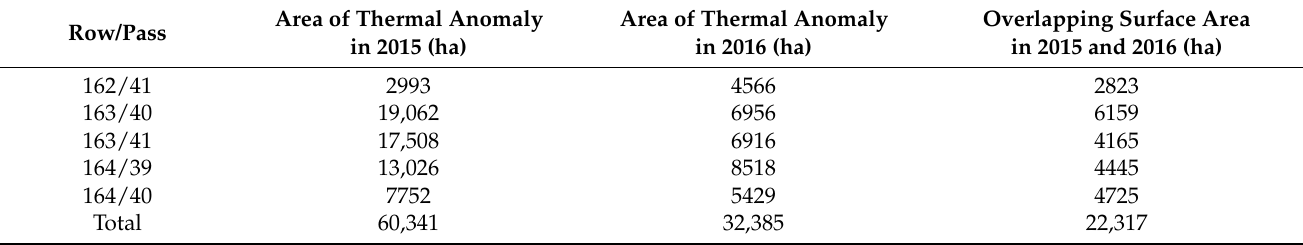
Table 1. The area of thermal anomalies in 2015 and 2016 and their overlapping surface area for each Row/Pass pair. (The Row refers to the latitudinal center line of a frame of imagery while the Path is a line that the satellite moves along it).